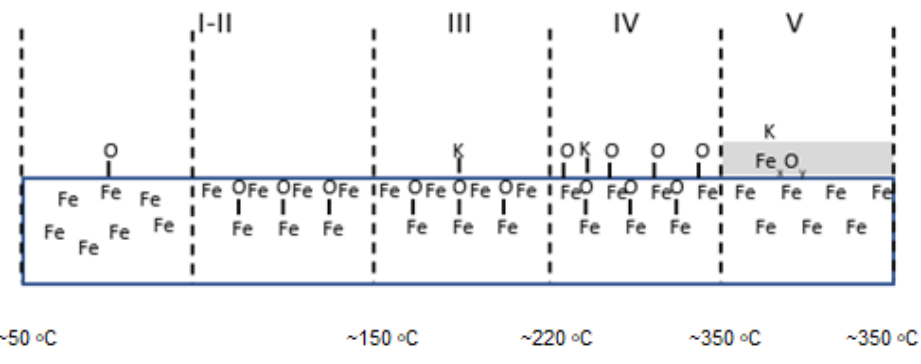
Figure 10. Schematic picture of surface structure of the Fe-Al sample.